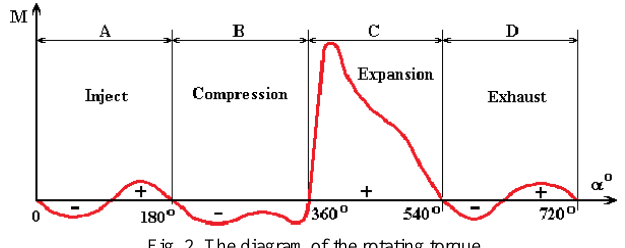
Fig. 2. The diagram of the rotating